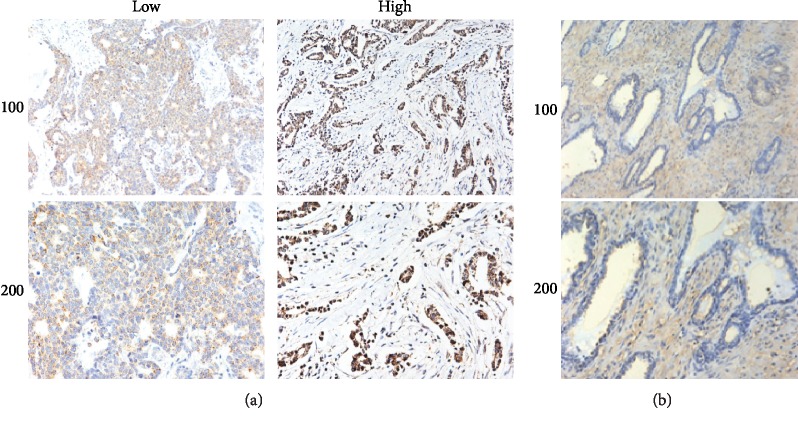
AK4 was highly expressed in human HER2-positive breast cancer tissues. (a) IHC assays were performed, and the representative photographs of AK4 expression levels in HER2-positive breast cancer tissues were detected and shown (×100 and ×200 magnification, respectively). (b) IHC staining showed AK4 expression levels in adjacent nontumor tissues (×100 and ×200 magnification, respectively).